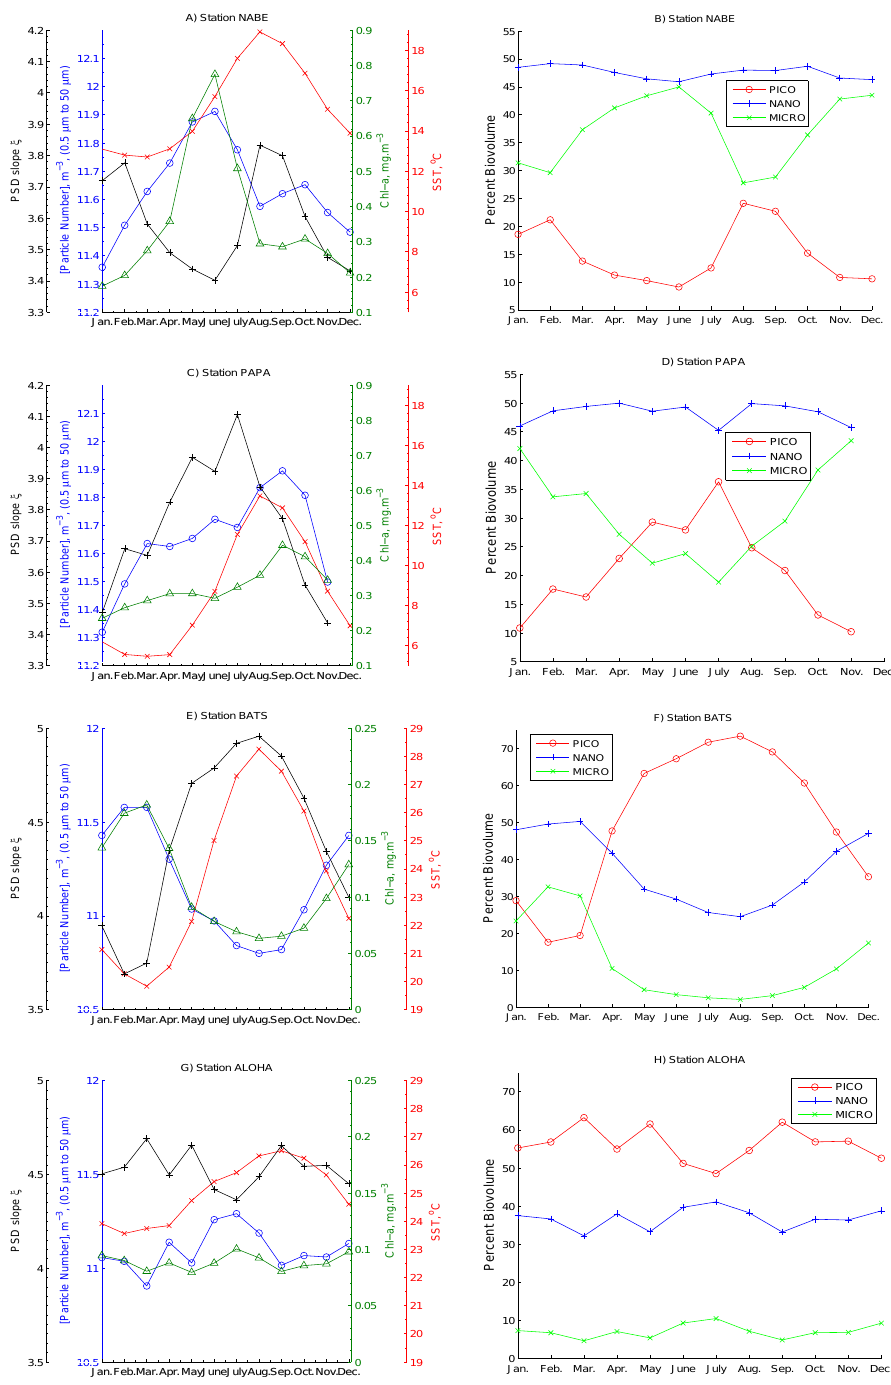
Fig. 8. Monthly decadal average time-series of PSD slope (black), phytoplankton-sized (0.5 to 50µm in diameter) particle number concen- tration (blue), SeaWiFS Chl (green), and AVHRR SST (red), plotted on the left panels and SeaWiFS-derived PFT’s, % picoplankton (0.5 to 2µm), % nanoplankton (2 to 20µm), and % microplankton (20 to 50µm ) (right panels) for four temperate and subtropical North Hemisphere sites: ( A and B ) North Atlantic Bloom Experiment (NABE), nominally at 47 ◦ N, 20 ◦ W; ( C and D ) the Northeastern Pacific Station PAPA, nominally at 50 ◦ N, 145 ◦ W; ( E and F ) the Bermuda Atlantic Time Series (BATS) station, nominally at 31 ◦ 50 0 N, 64 ◦ 10 0 W, and ( G and H ) station ALOHA near the Hawaiian Islands, nominally at 22 ◦ 45 0 N, 158 ◦ 00 0 W. The SeaWiFS monthly decadal averages are based on Sep 1997 through Dec 2007. AVHRR average was based on the complete years 1997 through 2007. The median of all valid pixels from each month’s decadal average image in a 1-degree box containing the respective station was